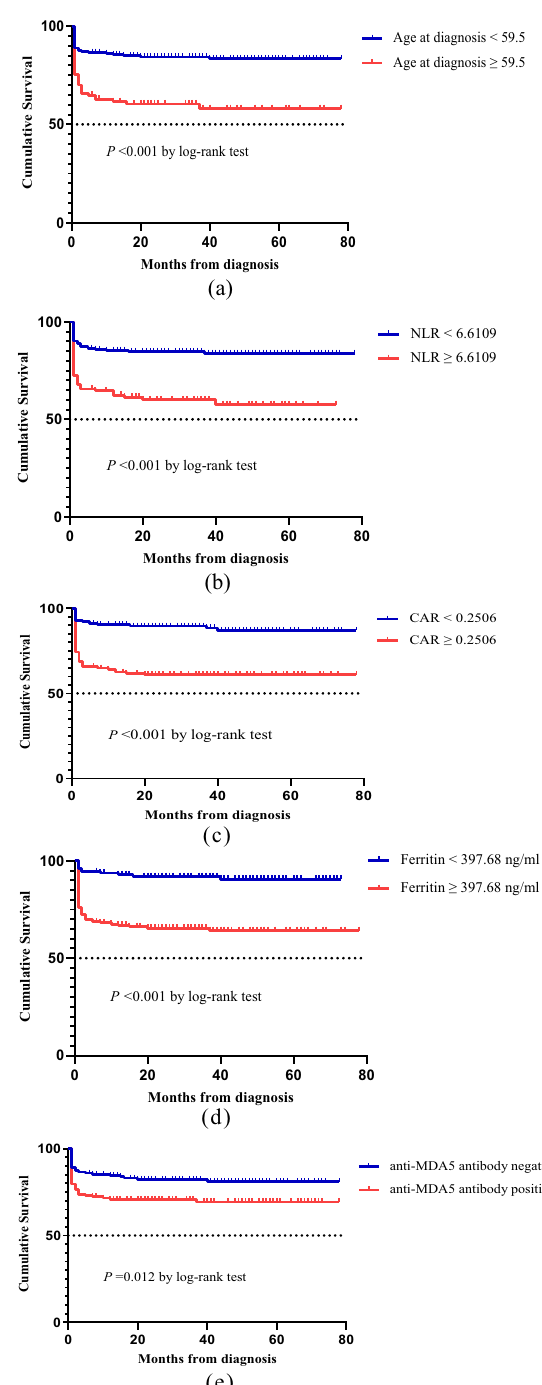
Figure 2. Survival curves for overall survival in patients with idiopathic inflammatory myopathy—associated Interstitial lung disease, stratified by age at diagnosis ( a ), NLR ( b ), CAR ( c ), ferritin ( d ) and anti-MDA5 antibody positive ( e ). NLR, neutrophil-to-lymphocyte ratio; CAR, C-reactive protein to albumin